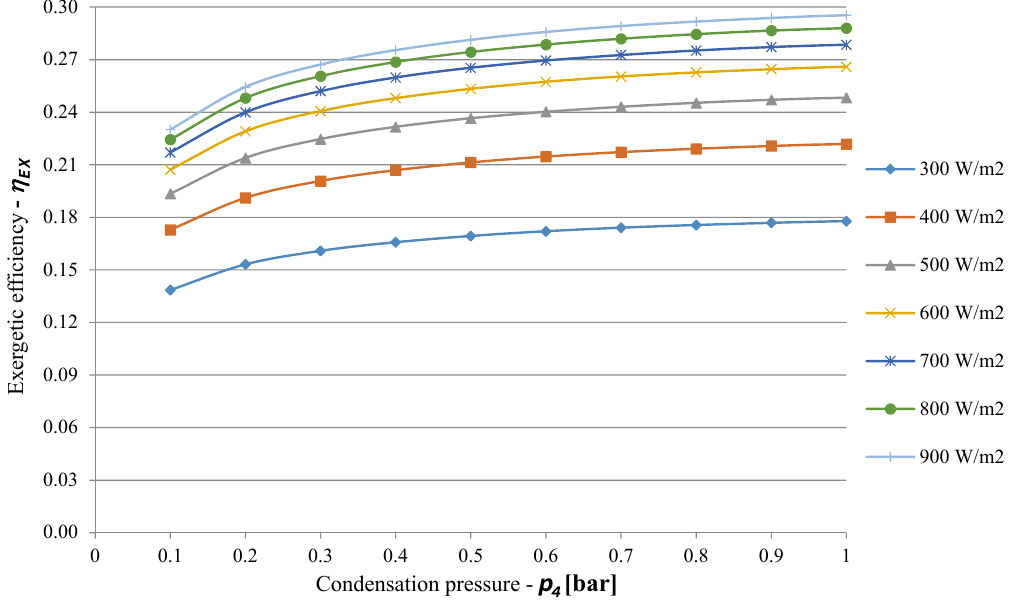
Figure 10. Exergetic efficiency versus condensation pressure under increasing solar radiations when the evaporation temperature is set at 230 °C.